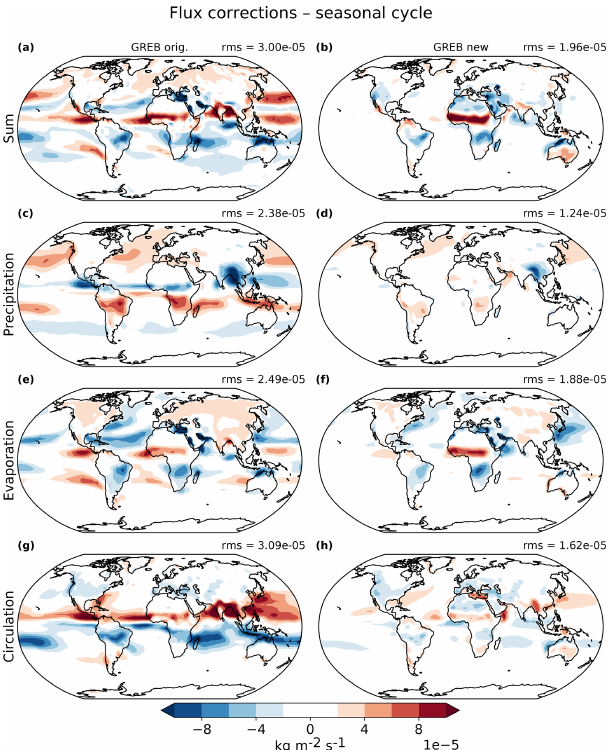
Figure 7. As Fig. 6 but for the seasonal cycle (DJF minus JJA). Flux corrections of specific humidity for the original GREB model (a) and the improved GREB model (b) . The flux corrections are then split into their contributions of precipitation (c, d) , evaporation (e, f) and circulation (g, h) for the original GREB model (a, c, e, g) and the improved GREB model (b, d, f, h) in kgm − 2 s − 1 . The top right corner of each panel shows the global rms.